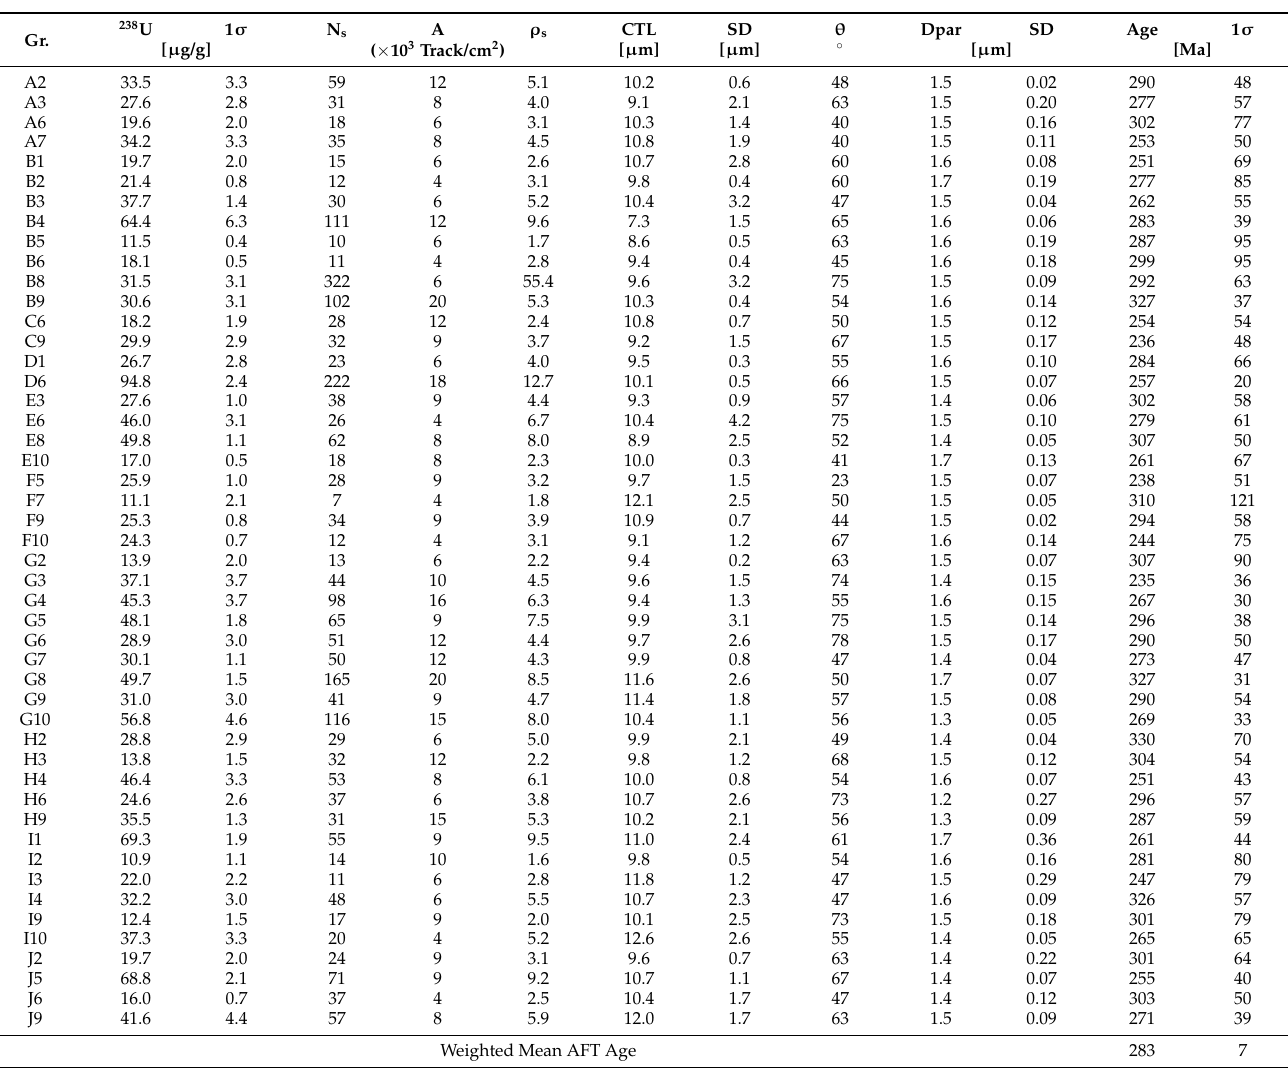
Gr = Grains, A1 grain symbol, U; Uranium concentration in ppm, 1 σ = uncertainty of 1-sigma, Ns; number of spontaneous tracks, A; Area in square microns, ρ s; density of spontaneous tracks (10 3 tr/cm 2 ), CTL; confined track lengths, SD; Standard deviation of CTLs, θ ; Angle from the c-axis in degrees, W.M. age; weighted mean age in million years calculated according to the equation in